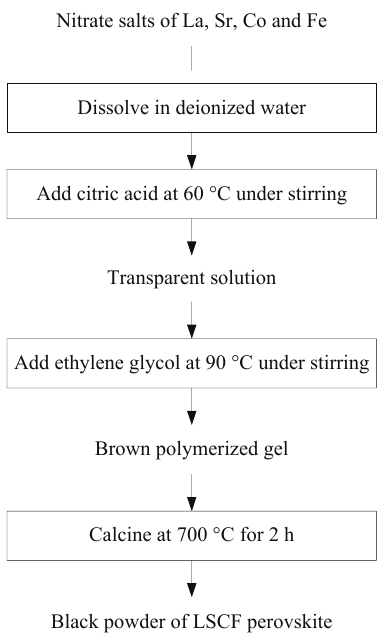
Figure 10. Flow chart of the Pechini method for synthesis of LSCF